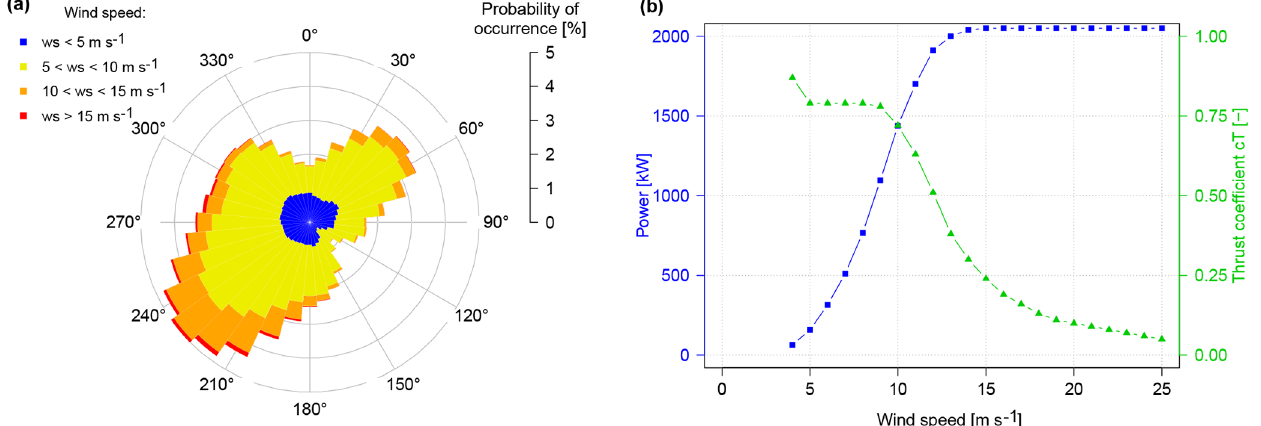
Figure 2. Long-term wind rose observed at the site of the SMV wind farm (a) and Senvion MM82 guaranteed power and thrust coefficient ( c T ) curves (b)